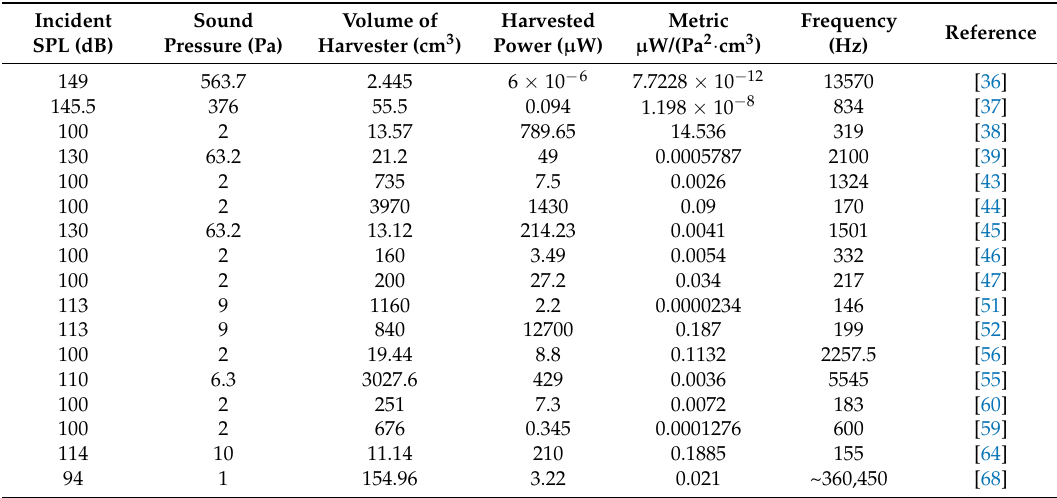
Table 3. Acoustic Energy Harvesting (AEH) performance comparison.